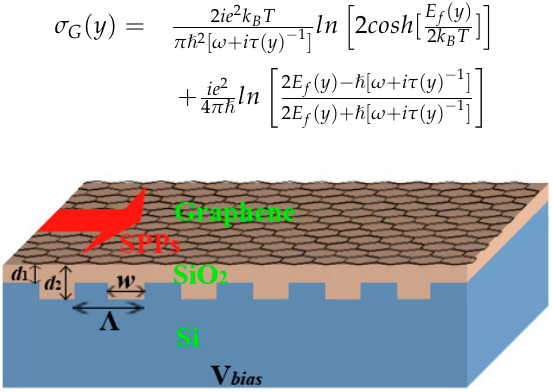
Figure 1. Schematic of the structure of a plasmonic Bragg reflector and the structure parameters are w = 40 nm and Ʌ = 80 nm. Voltage V bias is applied between graphene and silicon grating.